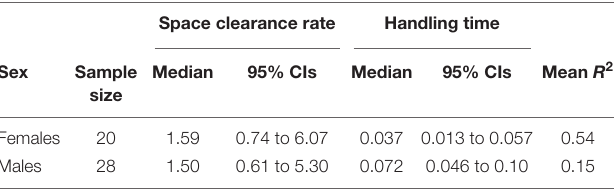
fits (0.54 for females and 0.15 for males) indicate considerable unexplained variation in foraging across individuals ( Table 1